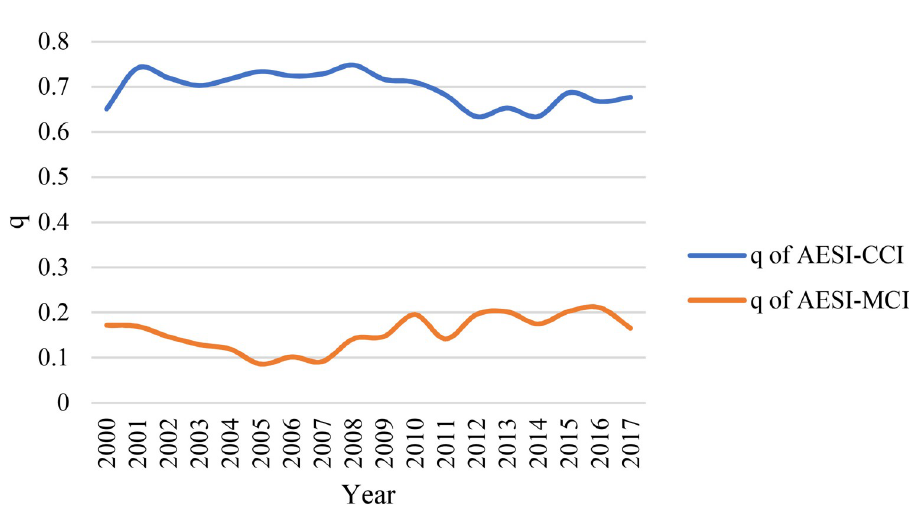
Fig 6. q of AESI-CCI and AESI-MCI (p-value is less than 0.01 every year).